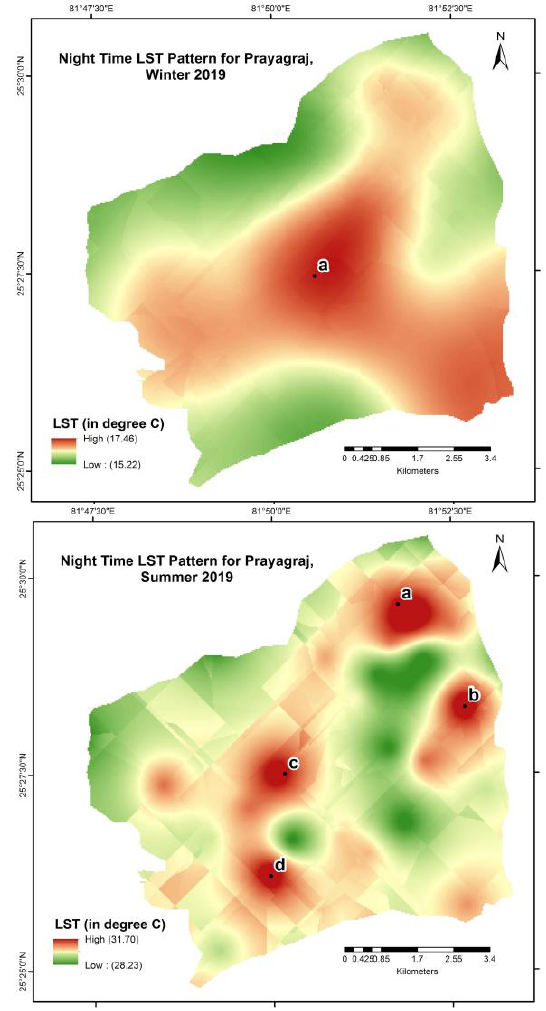
Figure 5. Night time LST profile of Prayagraj for winter and summer,